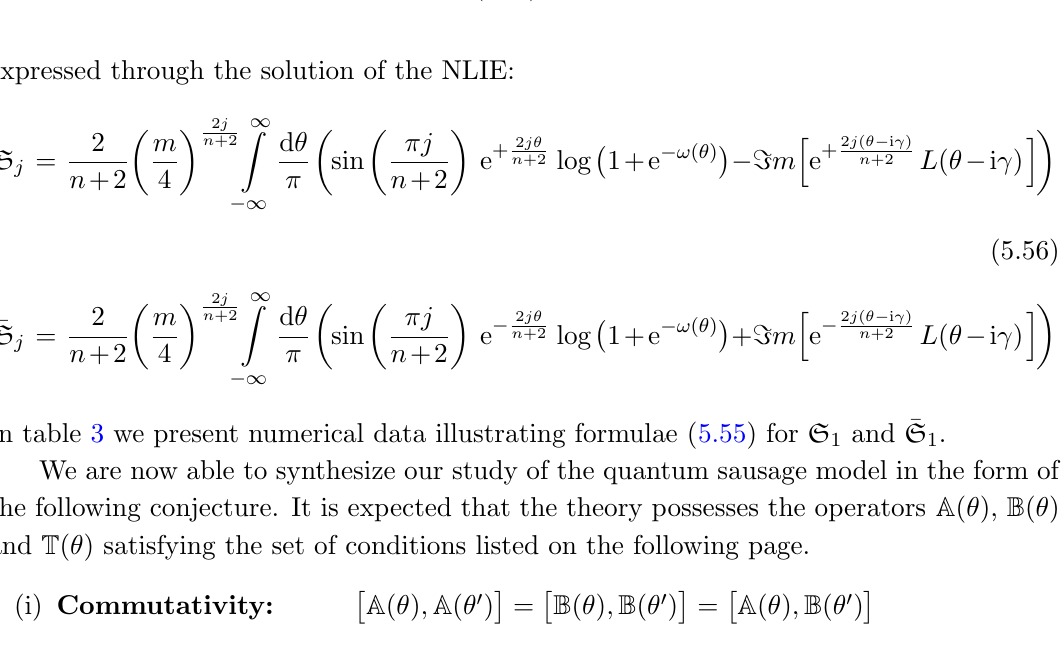
Table 3 . The vacuum eigenvalues of the dual nonlocal IM S 1 , (cid:22) S 1 and S for n = 9 5 . Eq. (5.56) was used to (cid:12)nd the numerical values of S 1 , (cid:22) S 1 from the solution to the NLIE, 13 whereas the corresponding formula for S is (5.59). The vacuum eigenvalues ~ s 1 ( p 1 ; p 2 ) of the chiral dual nonlocal IM are given by (4.84) and the expression for S is the solution of the quantization condition